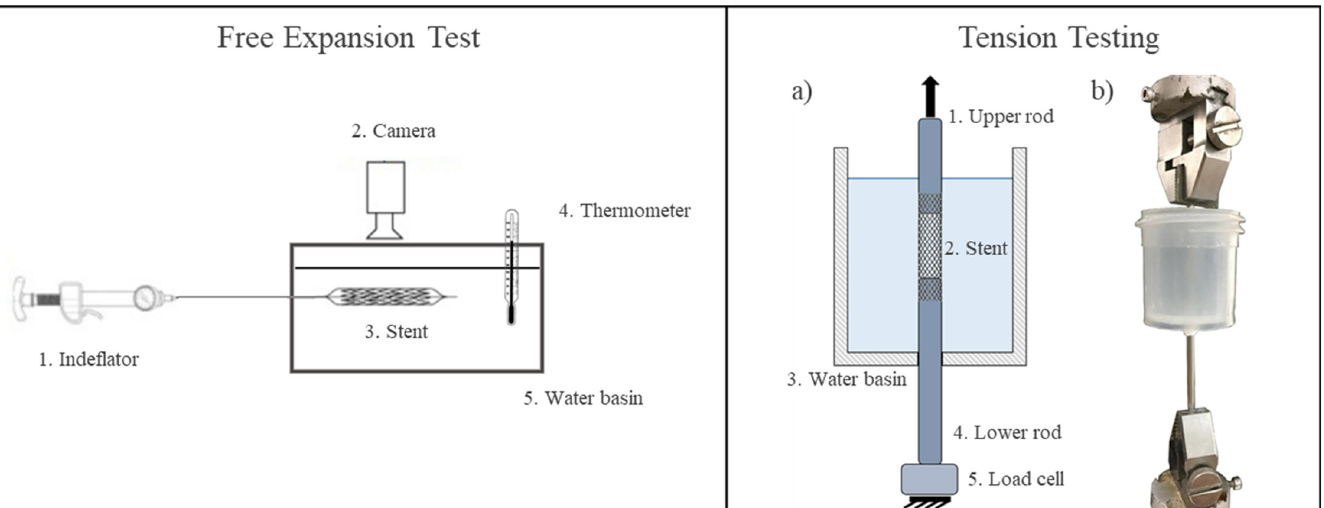
PLOS ONE | https://doi.org/10.1371/journal.pone.0252788 June 4,